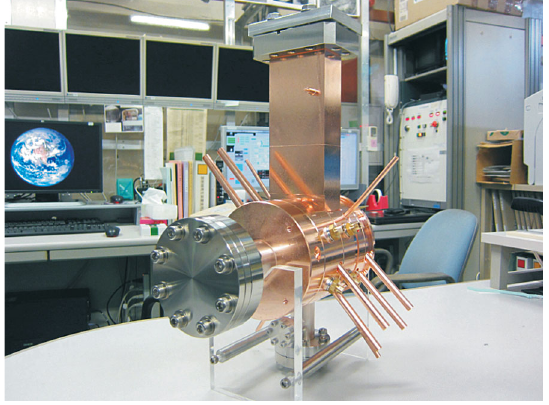
FIG. 9 (color online). Photograph of ECC-rf gun cavity. Cathode insertion port (near side), beam port (far side), rf waveguide (top), and vacuum pumping port (bottom). Water cooling pipes and rf tuners can be seen around the cavity.